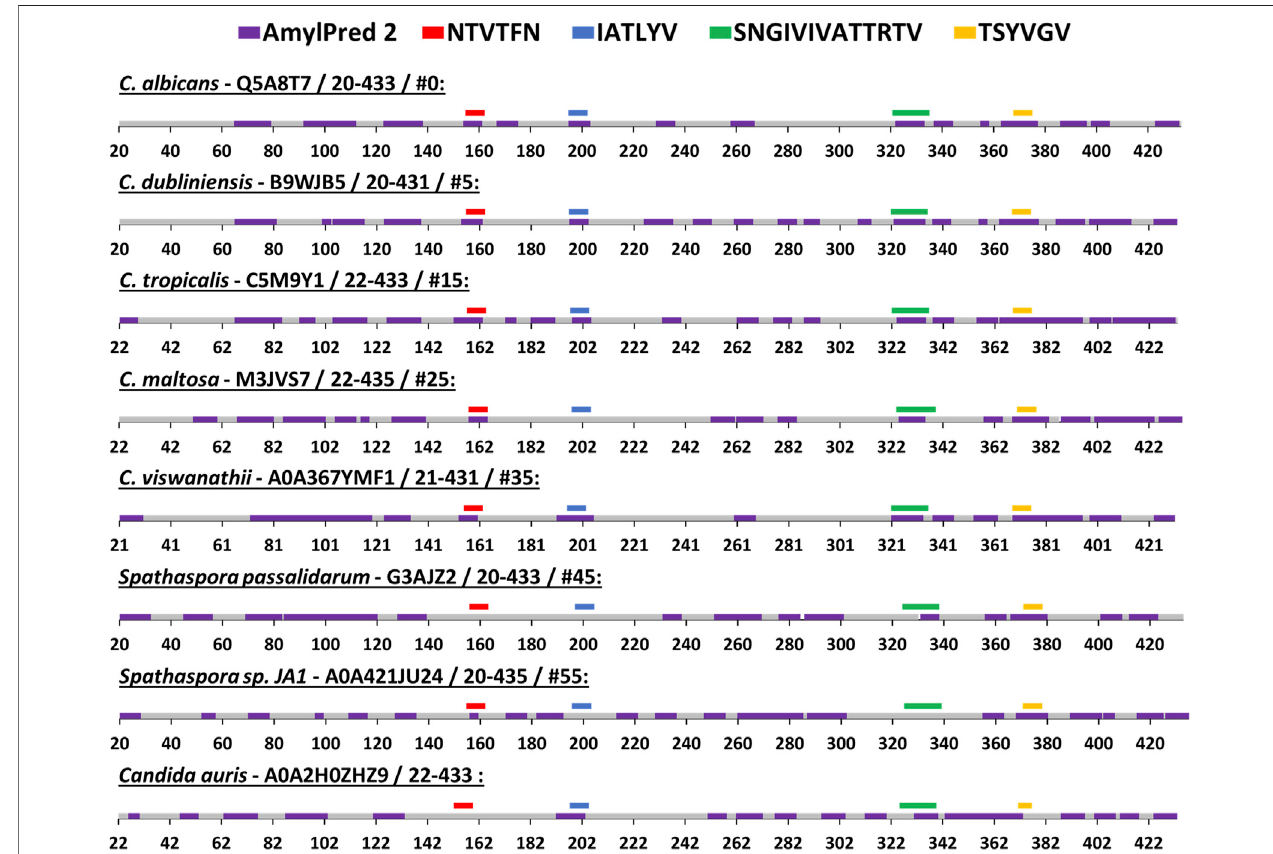
FIGURE 5 | Predicted segments with amyloidogenic propensities in the Als5 Ig-like/invasin and T regions of C. albicans and seven orthologs. The amyloidogenic propensity,calculatedusingtheAmylPred2server(Tsolisetal.,2013),ofAls5Ig-like/invasinandTdomainsof C.albicans andsevenorthologs.Thesespeci fi corthologs were chosen as a diverse group among the 71 homologs collected by the ConSurf webserver along with C. auris , as described in the Method section. Each ortholog is identi fi ed by the name of the species, their Swissprot ID, residue range of the Ig-like/invasin and T regions and their similarity to C. albicans ranked among 71 homologs(determinedusingtheConSurf-generatedmultiplesequencealignmentandmarkedwith#).Theregionswithpredicted amyloidogenicpropensityaremarked purple on the sequences, represented as alinear stretch with residue position marks. Regions equivalent to the C. albicans sequences are marked above the sequence with different colors as indicated: 156 NTVTFN 161 (red), 196 IATLYV 201 (blue), and 369 TSYVGV 374 (yellow) and 322 SNGIVIVATTRTV 334